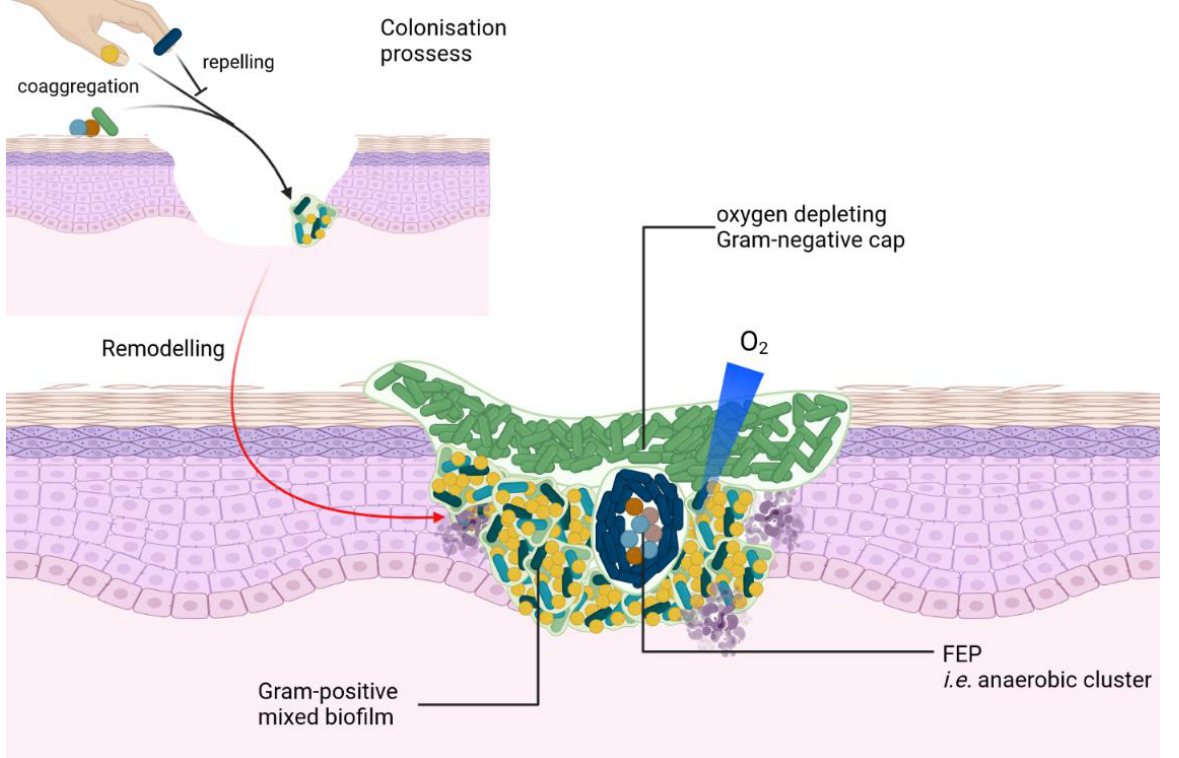
Figure 1. Biofilm organization at the wound level. Commensal and pathogenic bacteria colonized the wound through coaggregation/repelling either from the adjacent skin or through hand carriage. Arrows represent positive interactions, while the flathead arrow represents negative interactions. Time evolution is represented with a shaded red arrow. Bacteria are represented encased in biofilm matrix (green), which will remodel itself relying on bacterial interactions to further cover the wound. Biofilm is in contact with intact or necrotic cells of the different epidermal layers. Gram-negative, strict aerobes are represented in green and can “cap” the ulcer, and Gram-positive anaerobe/aerotolerant cocci are in yellow. Functionally equivalent pathogroups (FEPs) are illustrated at the core of Corynebacterium (dark blue bacilli) microniche as an anaerobic cluster of Gram-positive (brown, light brown, and blue). The dioxygen gradient is represented as a gradient blue triangle.